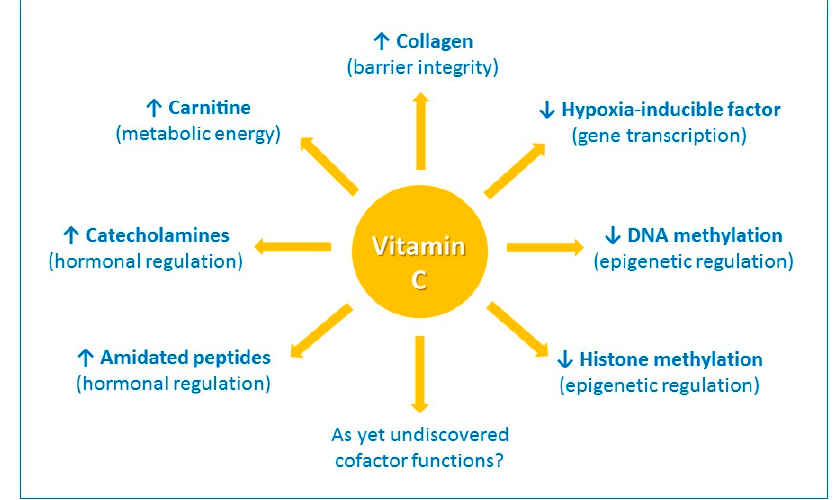
Figure 1. The enzyme cofactor activities of vitamin C. Vitamin C is a cofactor of a family of biosynthetic and gene regulatory monooxygenase and dioxygenase enzymes. These enzymes are involved in the synthesis of collagen, carnitine, catecholamine hormones, e.g., norepinephrine, and amidated peptide hormones, e.g., vasopressin. These enzymes also hydroxylate transcription factors, e.g., hypoxia-inducible factor 1 α , and methylated DNA and histones, thus playing a role in gene transcription and epigenetic regulation. ↑ indicates an increase and ↓ indicates a decrease.